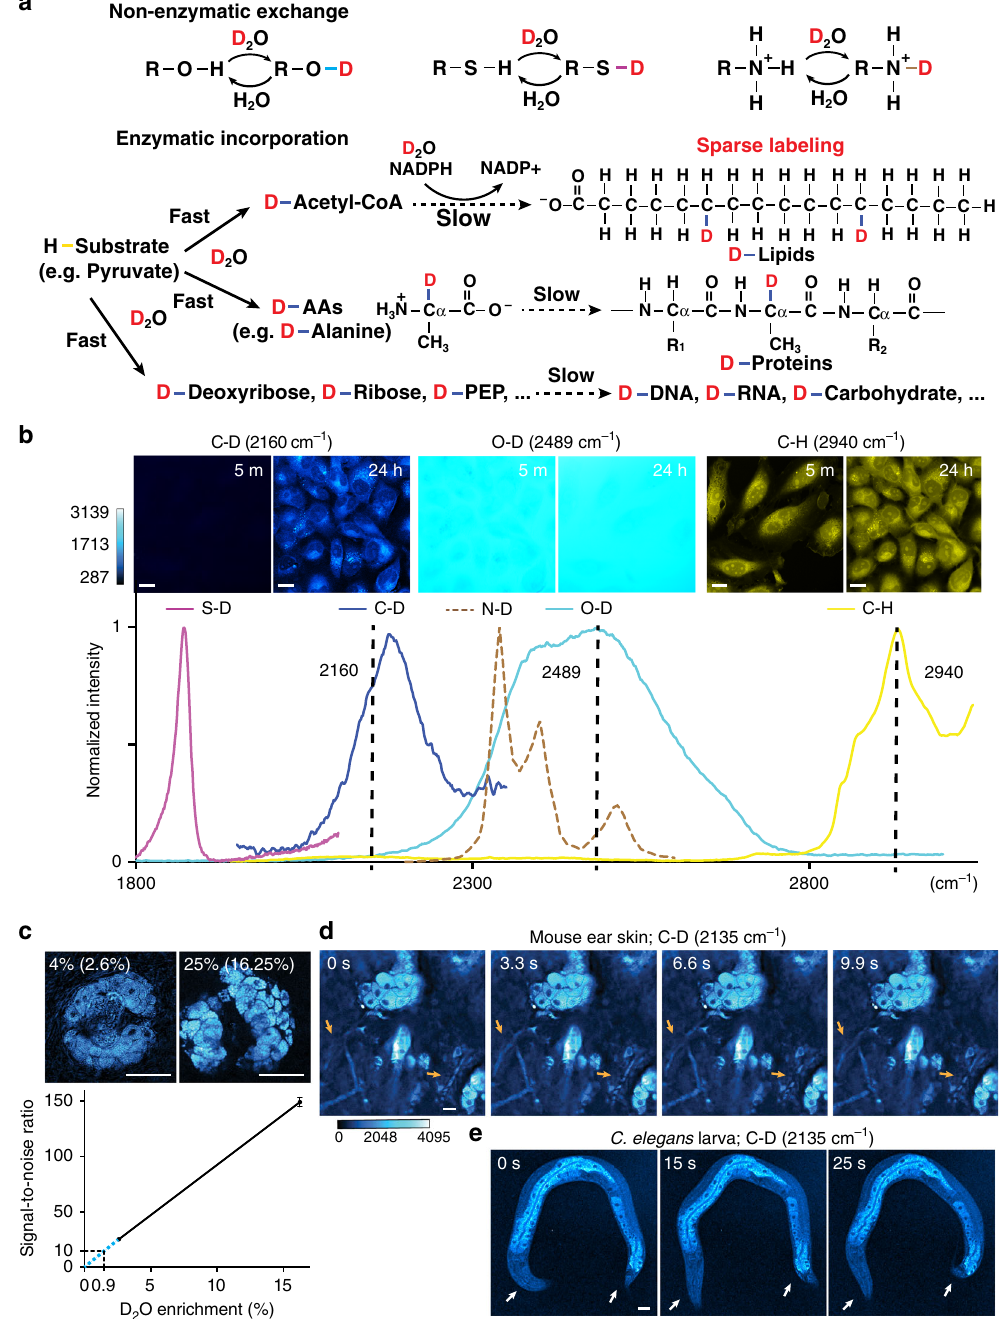
Fig. 1 SRS microscopic imaging of biosynthetic incorporation of deuterium from D 2 O into macromolecules in living cells and animals. a D 2 O-derived deuterium can form O – D, S – D, and N – D bonds through reversible non-enzymatic H/D exchange and be incorporated into C – D bonds of metabolic precursors for the synthesis of macromolecules through irreversible enzymatic incorporation. Note that, under the condition of sparse labeling, the position of deuterium labeling on lipids is random, and this illustration only represents one possible labeling pattern. b Various X – D bonds produced Raman peaks at distinct positions. C – D, C – H, and O – D spectra were collected from Hela cells grown in 70% D 2 O medium, S – D spectrum from saturated cysteine dissolved in D 2 O, and N – D spectrum adopted 65 . SRS microscopic images were collected for C – D, O – D, and C – H signal of HeLa cells at 5 min and 24 h after adding D 2 O-containing medium. c Signal-to-noise ratio (S/N; noise = 1 μ V) for SRS microscopic signal of sebaceous glands at 2135 cm − 1 from mice that drank 4% or 25% D 2 O for 8 days. Percentages of D 2 O enrichment in body water are shown in parentheses. Detection limit at S/N = 10 or 2 was calculated based on the linear relationship between average S/N and D 2 O enrichment level. d , e Frames from live SRS microscopic imaging recordings of the sebaceous glands under the ear skin of intact mice that drank 25% D 2 O for 9 days (Supplementary Movie 1 – 3) and living fourth stage C. elegans larva that grew on 20% D 2 O- containing NGM plates for 4 h (Supplementary Movie 4 – 6). The blood fl ow (orange arrows) in mouse visualized with two-photon absorption contrast and the movement of the C. elegans body (white arrows) indicated that the animals under imaging were alive. Scale bar = 20 μ m. C – D signal was shown in cyan hot LUT, and color scale bars display the scale for the lookup table